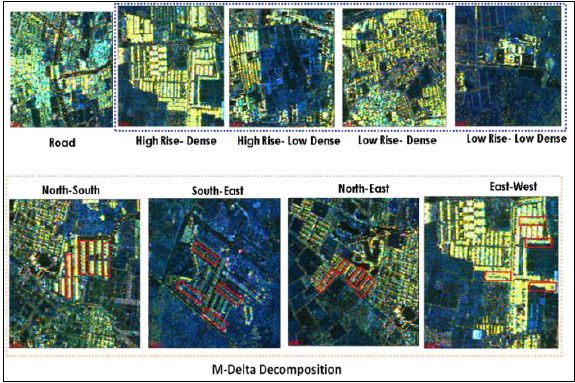
Figure 6: Different classes emphasizing in built-up area as shown in m-delta decomposed image